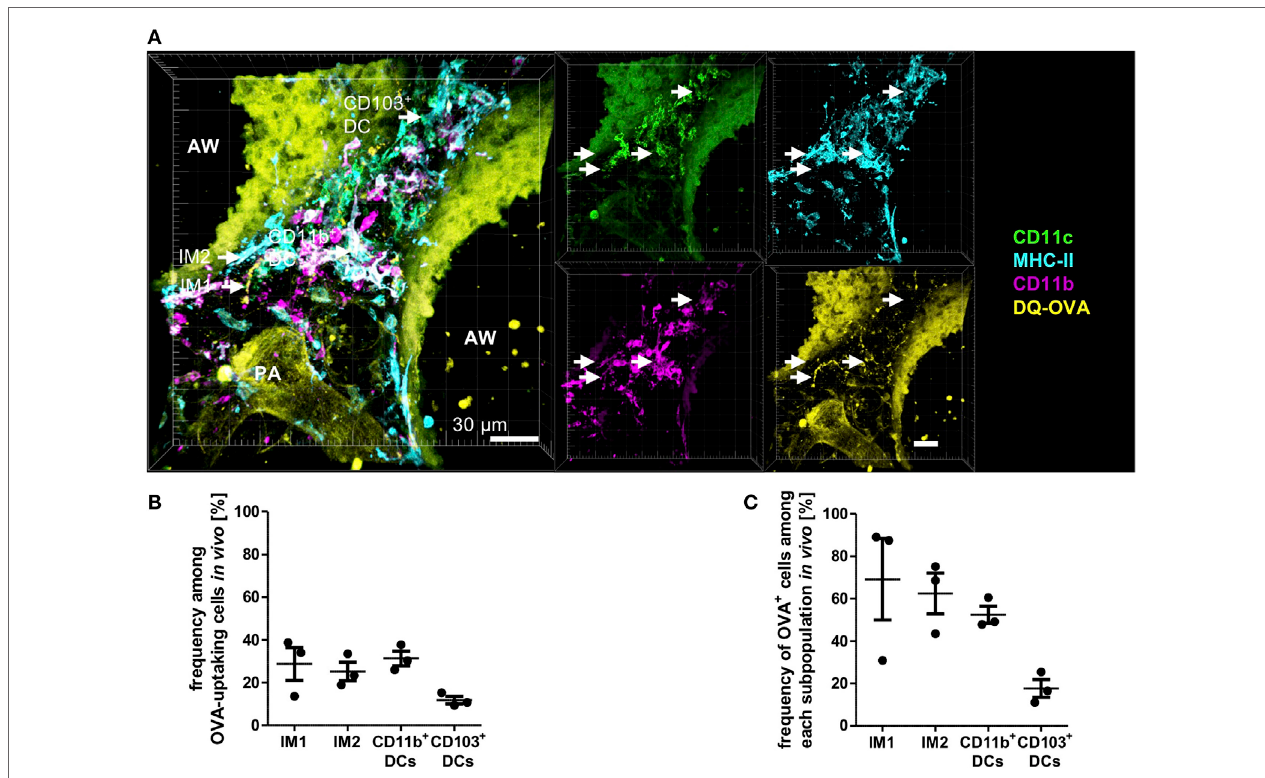
FigUre 6 | Interstitial macrophages (IM)1, IM2, and CD11b + dendritic cells (DCs) equally contribute to antigen uptake in the lung in vivo . C57BL/6 mice were anesthetized and immunized intratracheally with 100 µg house dust mite extract (HDM) mixed with 40 µg DQ-ovalbumin (OVA). Four hours after immunization, mice were sacrificed, and precision cut lung slices (PCLS) (300 µm) were generated and stained with anti-CD11c, anti-MHC-II, and anti-CD11b mABs. Stained slices were evaluated with confocal microscopy. Fluorescence of DQ-OVA was measured in the FITC-channel. (a) Single-color and merged color display with CD11c (orange), MHC-II (red), CD11b (blue), and DQ-OVA (green). Data are representative of four independent experiments. (B) Frequency of IM1, IM2, CD11b + conventional DCs (cDCs), and CD103 + DCs among OVA-uptaking cells. (c) Frequency of DQ-OVA + cells within each phagocyte subset. Lines indicate mean ± SEM. Differences between groups were tested by Kruskal–Wallis test (B,c) for